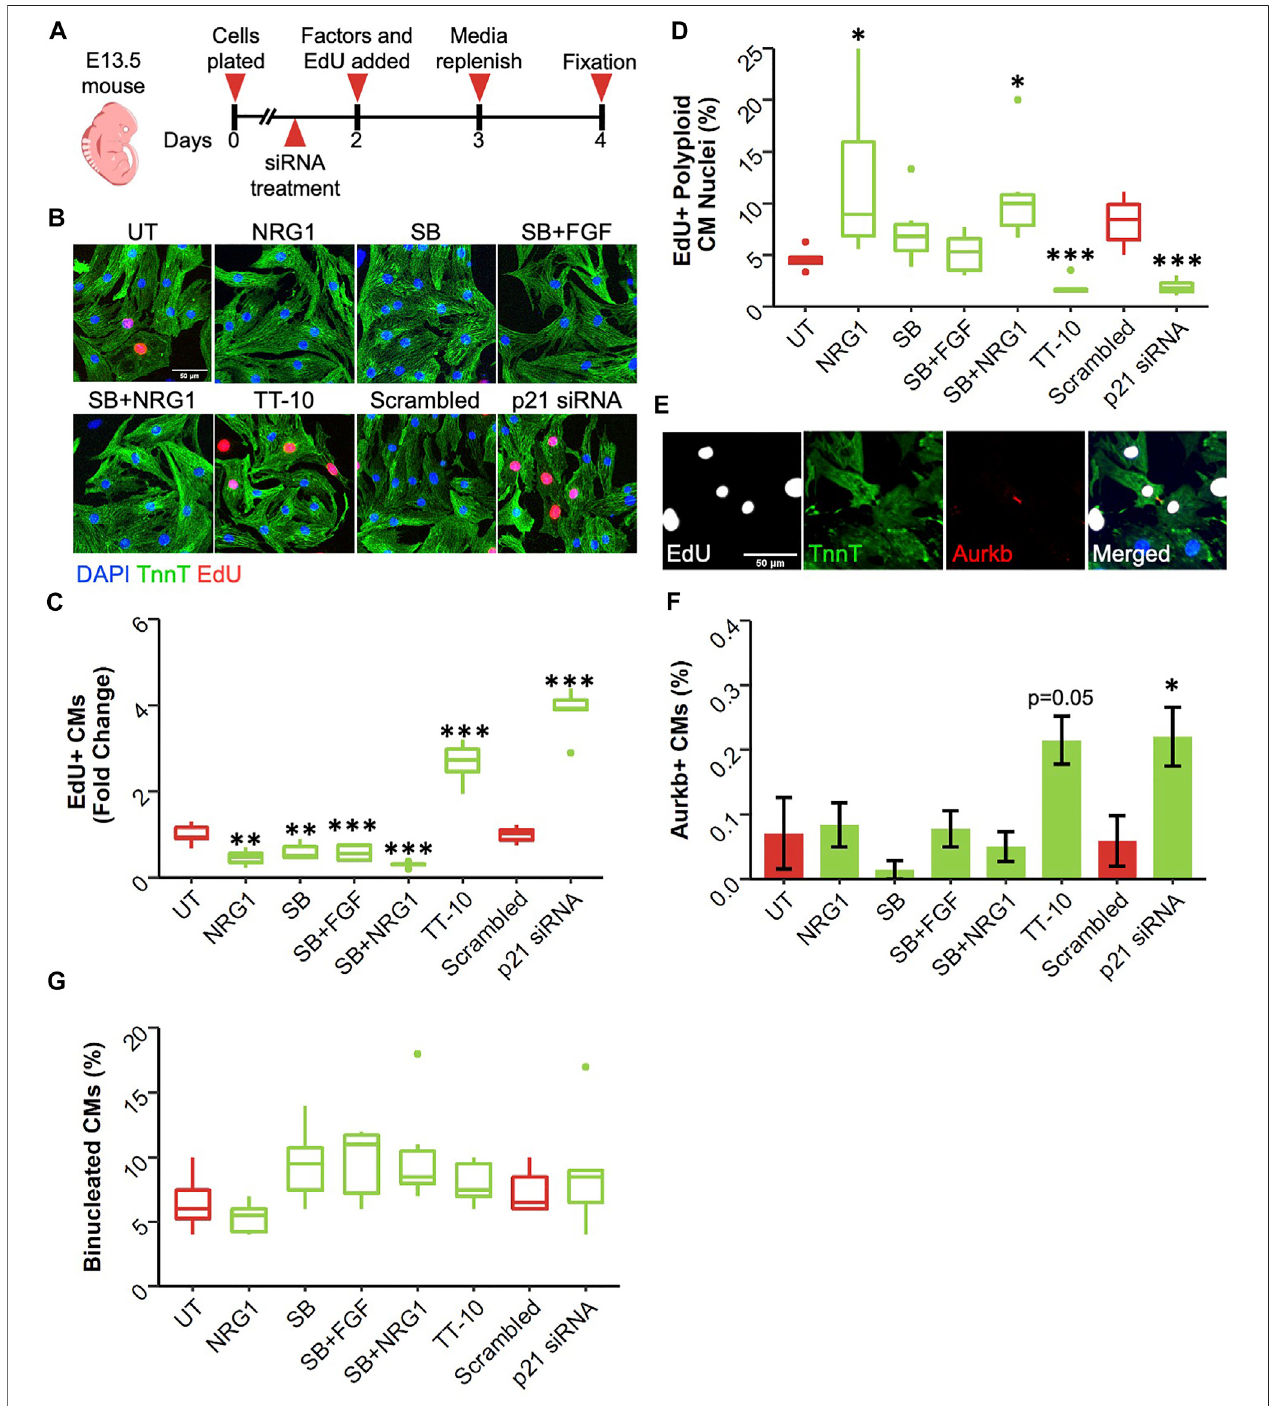
FIGURE3| EffectofproliferativestimulionmouseE13.5cardiomyocytes. (A) Experimentaloutline.E13.5mousecardiomyocyteswereisolatedand platedonDay 0, 36 h later siRNAs and 48 h later proliferative stimuli were added. Edu was added along with proliferative stimuli and was present for the last 48 h of culture. (B) Representative images of E13.5 murine cardiomyocytes stained for TnnT (green), EdU (Red) and DAPI (blue) (scalebar = 50 µm) (C) Quanti fi cation of Fold Change in relative EdU + CM nuclei ( n = 6 for each group, ** p < 0.01, *** p < 0.001) (D) Quanti fi cation of EdU + polyploid (4n+) nuclei based on DAPI histograms ( n = 6, * p < 0.05, *** p < 0.001) (E) Representative image of Aurkb +cardiomyocyte inthe process ofundergoing cytokinesis (F) Abundance ofAurkb +CMs relativeto total number of CMs after treatments ( n = 6 for each group, * p < 0.05) (G) Percentage of binucleated CMs at the end of culturing period ( n = 6 for each group).